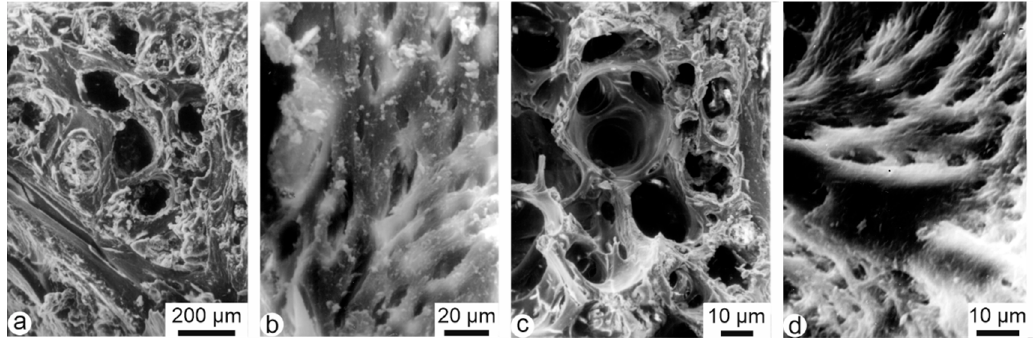
Figure 2. Structure of fresh fish bones, showing the natural cavities and the mineralized collagen fiber bundles in vertebrae of Bagrus ( a , b ), and Oreochromis ( c , d ).